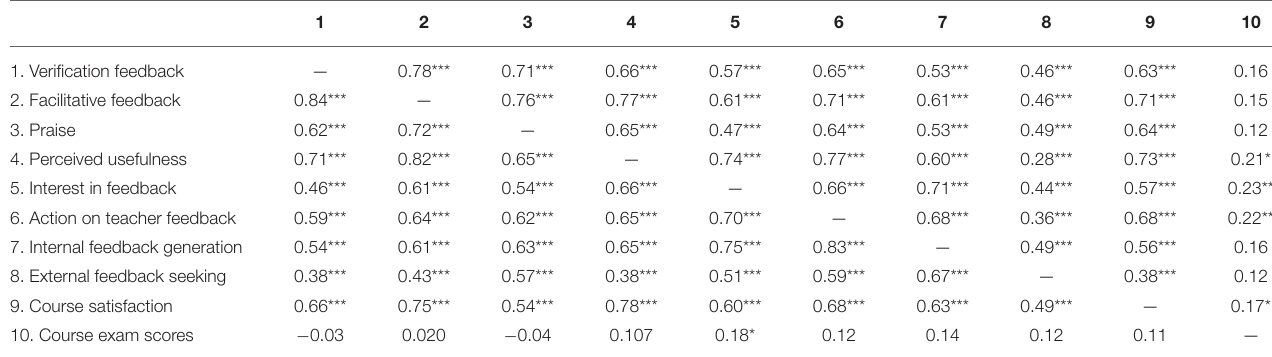
TABLE 3 | Zero-order correlations between teacher feedback practices, student feedback motivation and behavior, course satisfaction and course exam scores for students from the key and non-key university.